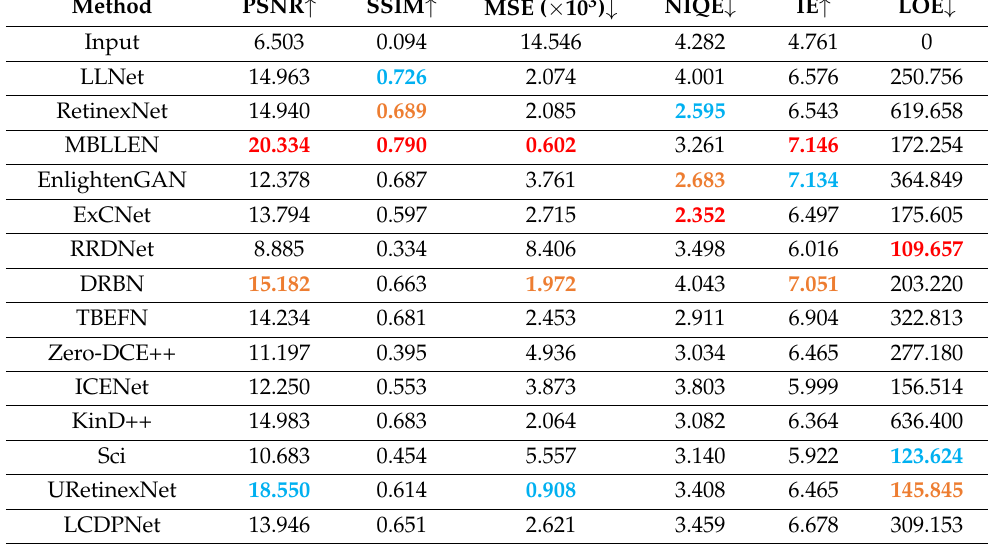
Table 5. Quantitative comparison of the SCIE datasets (Paired Dataset) according to PSNR, SSIM, MSE, NIQE, IE, and LOE. The best result is bold in red , the second result is bold in blue , and the third result is bold in yellow